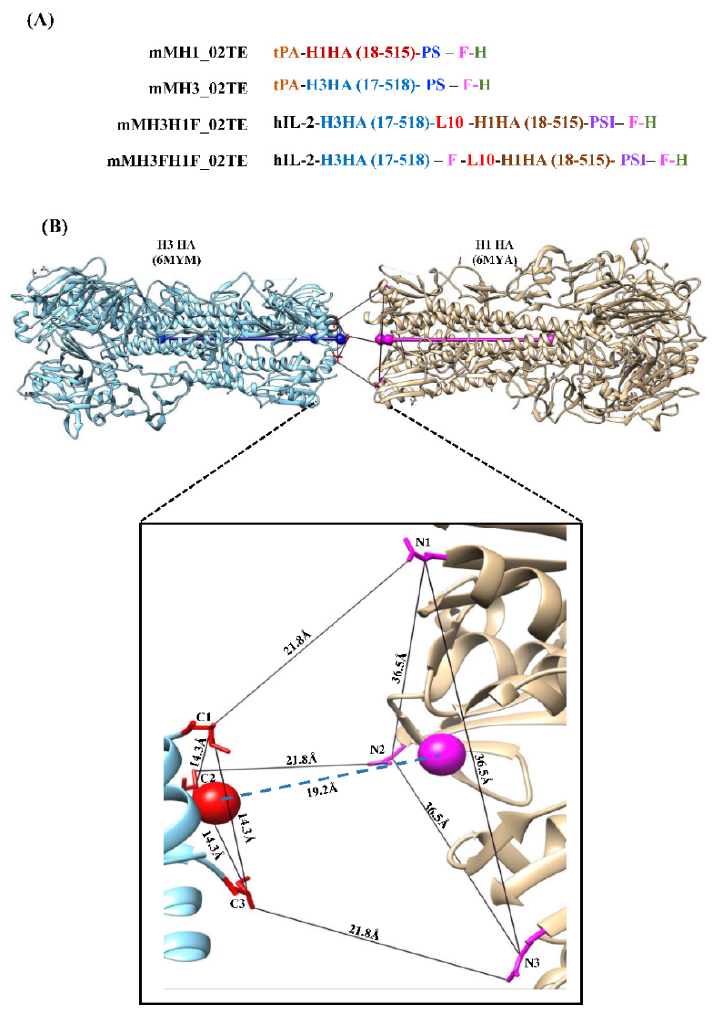
Figure 1. Hemagglutinin Ectofusion Immunogen Design. ( A ) Schematic representation of hemag- glutinin (HA) immunogen sequences. L10, PS, PSI, F, H represent a ten-residue linker, HRV3C pro- tease cleavage site, TEV cleavage site, foldon and histidine tag respectively. tPA and hIL-2 are signal peptides. H1 and H3 ectodomains consist of N-terminal tPA signal sequence followed by the HA ectodomain linked to a cleavable foldon trimerization domain and a C-terminal histidine tag . mMH3H1F_02TE immunogen comprises of hIL-2 signal sequence followed by the H3 HA ectodo- main, which is connected with the H1 HA ectodomain by a flexible 10 residue linker followed by a cleavable foldon trimerization domain and a C-terminal histidine tag. mMH3FH1F_02TE is similar to the above fusion but contains an additional foldon sequence between the H3 and H1 ectodomains. ( B ) For hemagglutinin ectofusion immunogen design , H3 ectodomain (PDB: 6YM) and H1 ectodo- main (PDB: 6MYA) were aligned along their 3-fold symmetry axes, shown in blue and pink, respec- tively, using UCSF Chimera Visualization software. Triangular planes defined by the three N and three C-termini respectively were separated by a perpendicular distance of 19.2 Å, to avoid steric clashes between molecules. In the hemagglutinin ectofusion modeled structure, the C-termini of H3 and N-termini of H1 HA are minimally 21.8 Å apart and were, therefore, connected using a ten- residue long flexible ‘GSA’ linker.